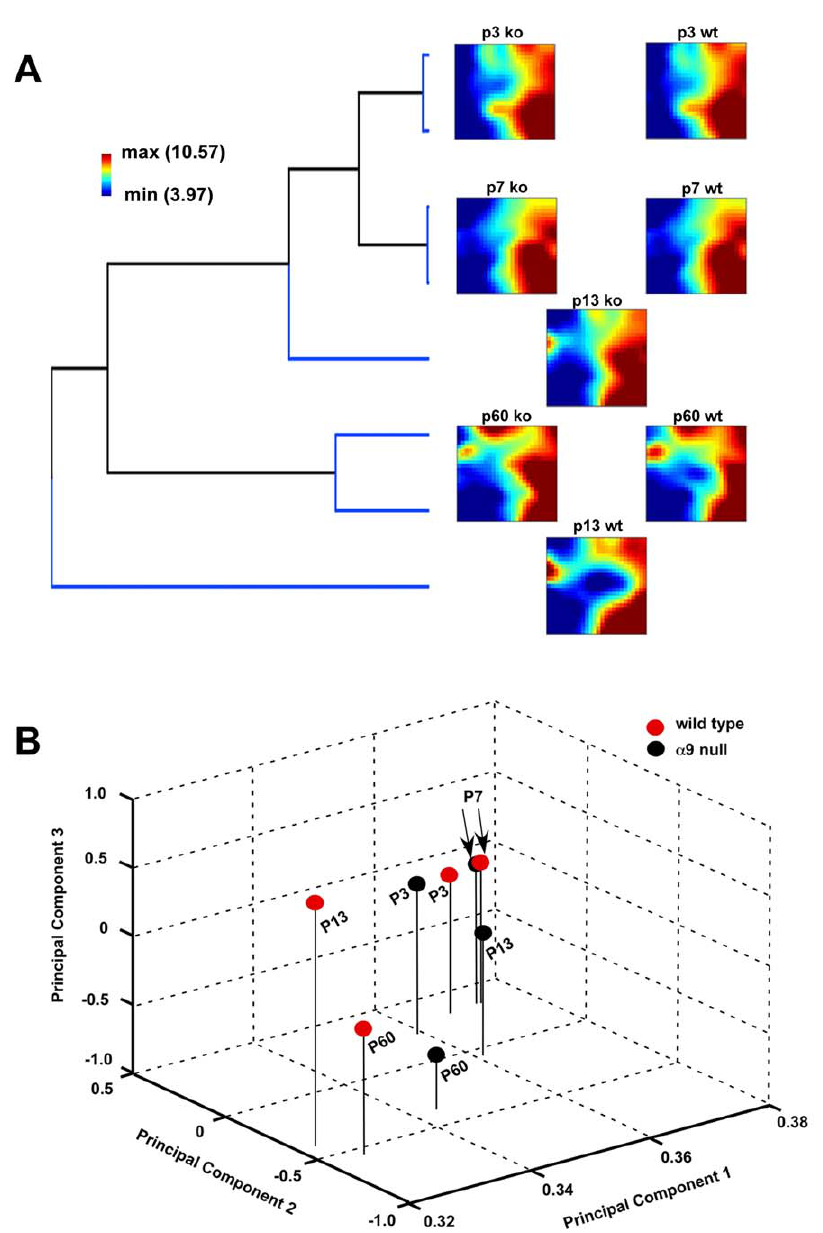
Figure 7. Comparison of dynamic gene expression levels of wild type and a 9 2 / 2 . ( A ) Hierarchical clustering of centroids indicates similarity between genotypes and across ages. Mosaic patterns are pseudo-colored SOMs of the 650 metagene profiles from developing wild type and a 9 2 / 2 cochleae. Each tile contains genes with similar expression patterns and the spatial location of each tile is preserved across maps. Tile colors indicate the expression level of the centroids, with red representing high expression and blue representing low expression. ( B ) Principal component analysis (PCA) comparing SOM centroids. Each sample is projected onto a three dimensional grid comprised of the first three (strongest) principal components. PCA indicates the differences between wild type and a 9 2 / 2 cochlea at P13 and